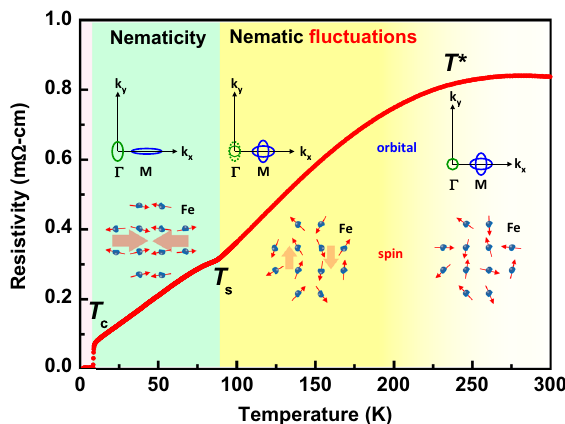
Fig. 4 Phase diagram of FeSe by nematic ultrafast dynamics. Temperature dependence of the resistivity ρ shows clearly an anomaly at T s and indicates the high quality of FeSe together with a large residual-resistance ratio (RRR). T* denotes the temperature at which ρ ( T ) shows a rapid change of slope. Insets illustrate the nematic evolution of charge and spin subsystems in various phases. The thin arrows indicate sketchily the individual moment of Fe ions. The thick arrows indicate the “ net ” magnetic moments of FeSe in the stripe form. The simpli fi ed FS in each temperature range is depicted. The picture of FS for T < T s follows ref. 49. The dashed green line denoted the proposed FS fl uctuations at the Γ